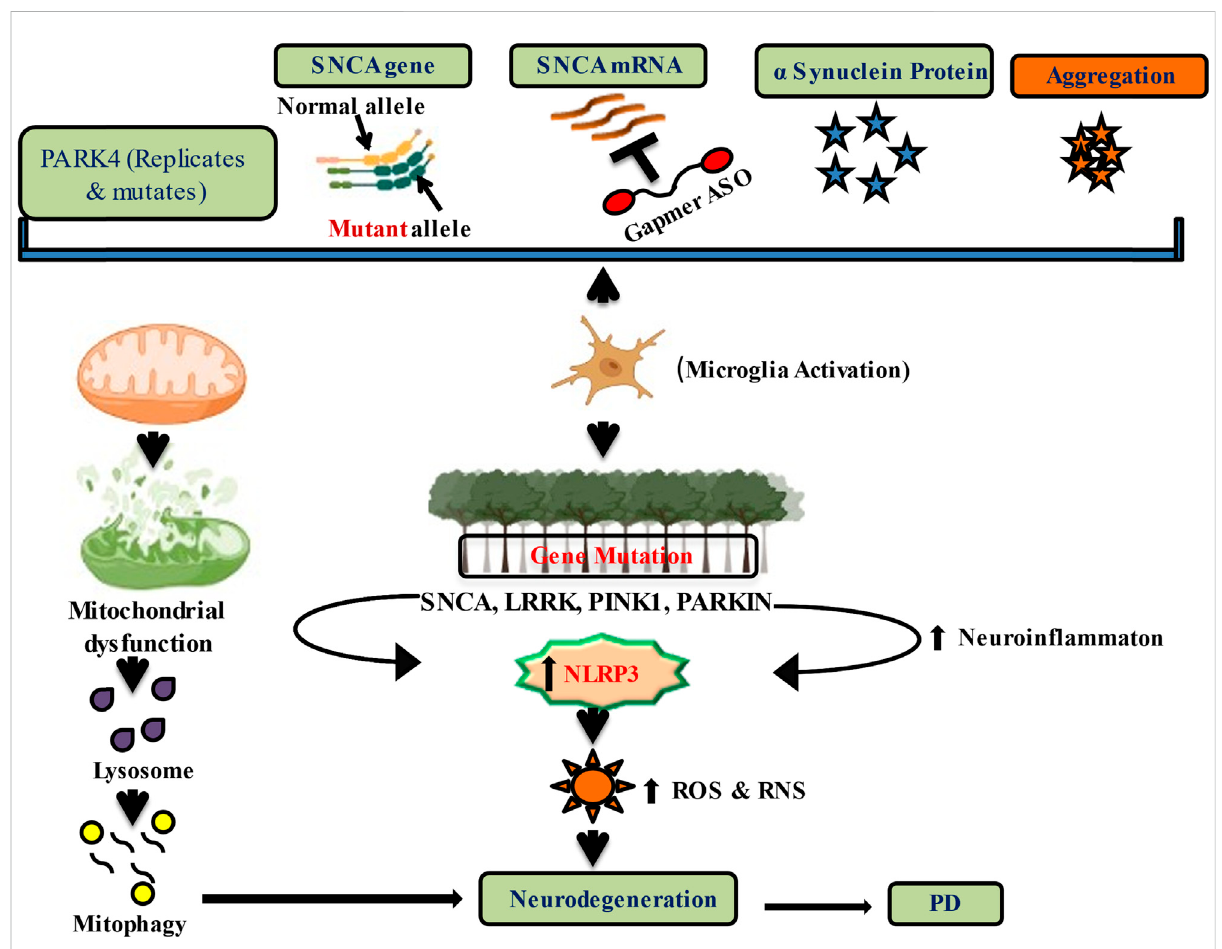
FIGURE 1 Downregulation of alpha-Synuclein expression and genetic regulation by nucleic acid therapeutics in